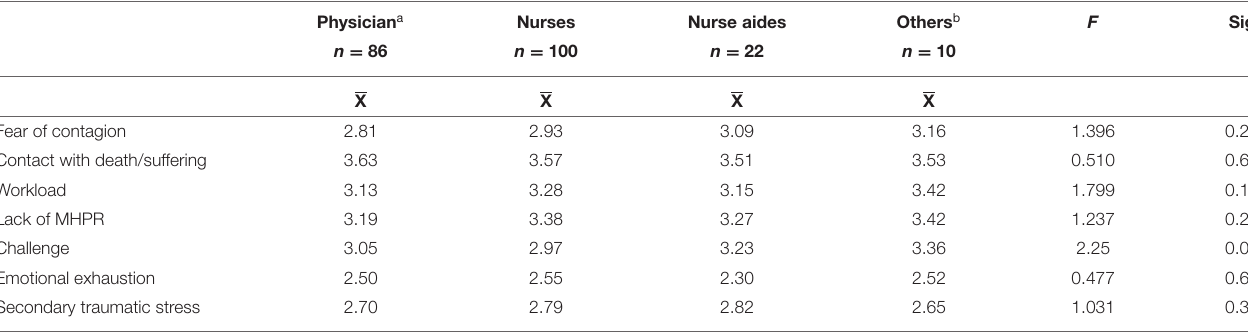
TABLE 5 | Mean differences between job